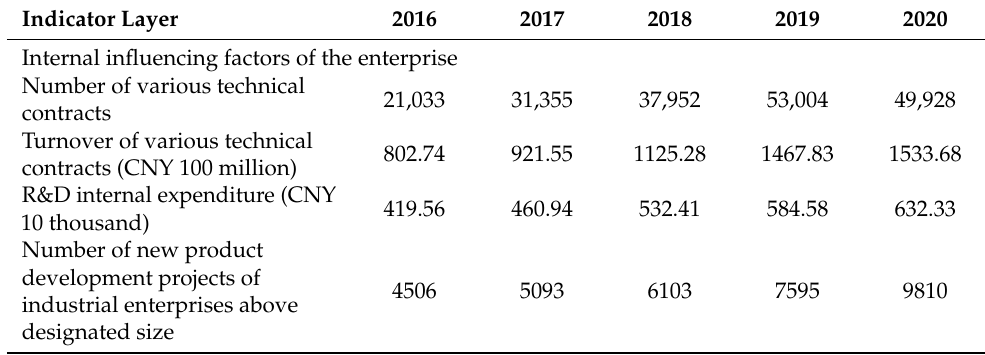
Table 4. 2016–2020 Shaanxi green supply-chain management diffusion